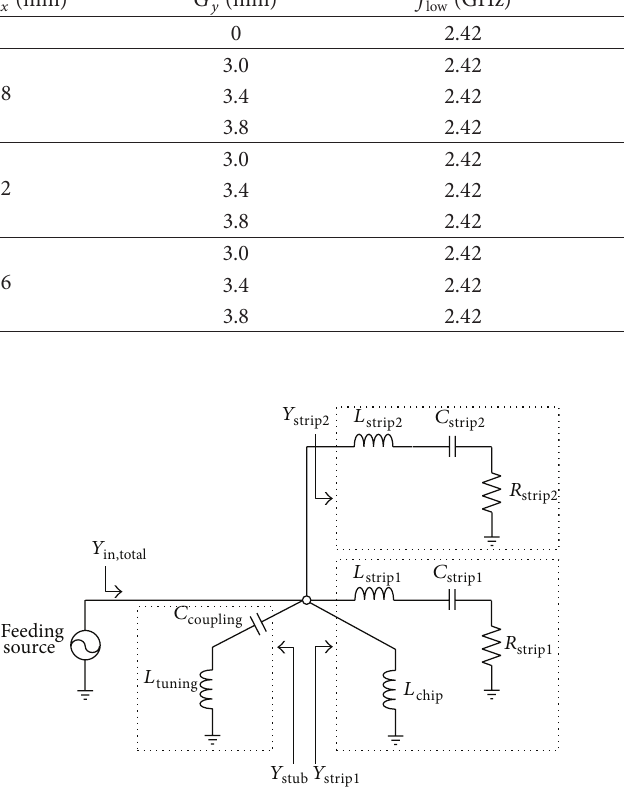
Figure 5: The equivalent circuit for the proposed WLAN antenna.